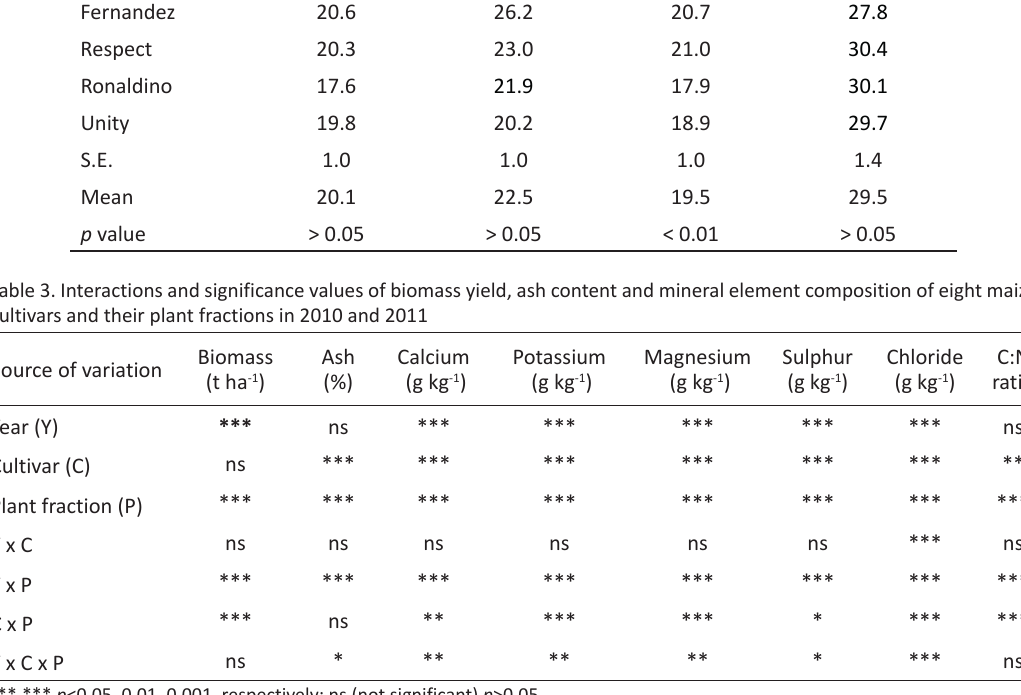
Plant fraction (P)